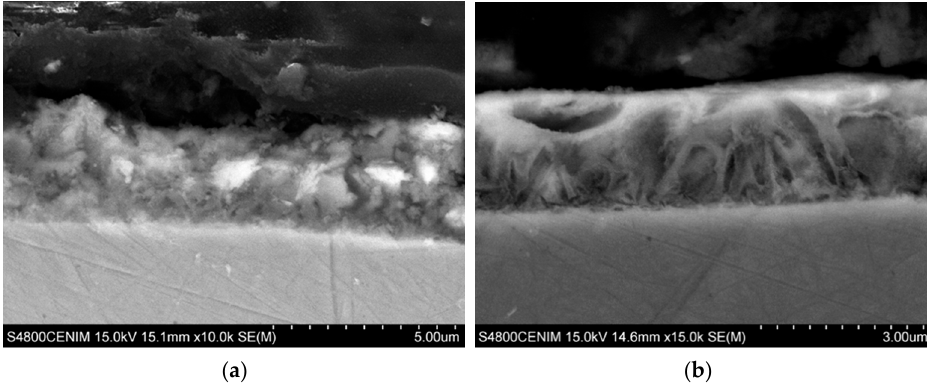
Figure 6. SEM images taken in cross sections at different position of the Hull cell specimen obtained in 0.3 M ZnCl2–0.1 M CeCl 3 –ChCl–Urea, at 0.25 A for 60 min: ( a ) Intense dark blue area (zone II-a) ×10,000 and ( b ) dark blue area (zone II-b) ×15,000.